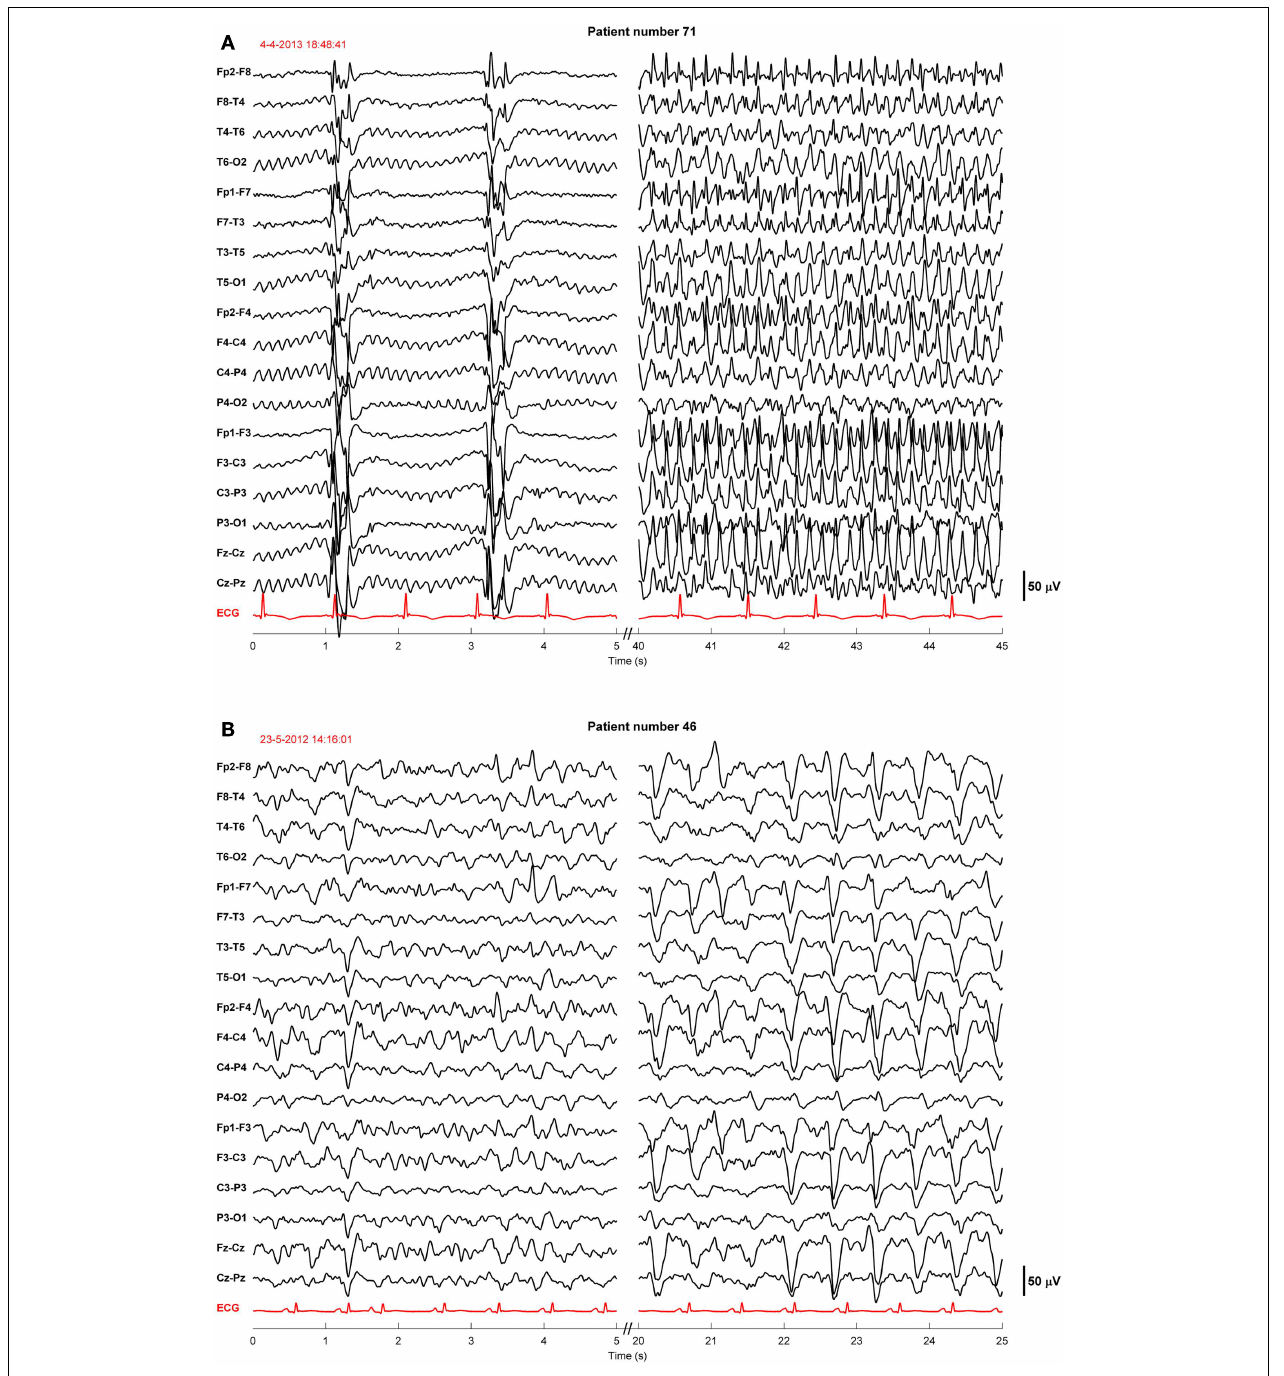
arrest, during therapeutic hypothermia (33°C) (A) , or 78h after cardiac arrest, after restoration of normothermia (B) . Filter settings, 0.5–30Hz.These patients had a poor